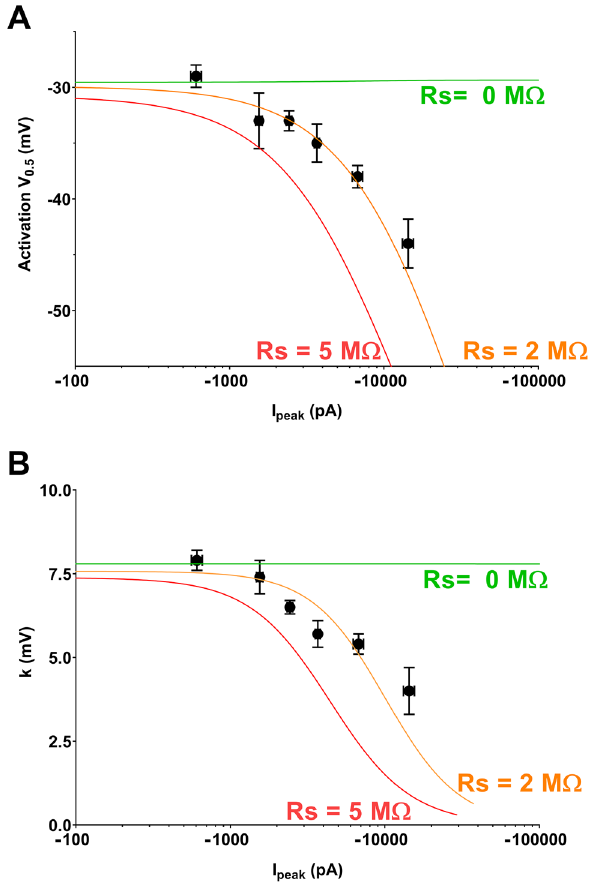
Figure 7. V 0.5 vs. amplitude plots and slope vs. amplitude plots of heterologously-expressed Na v 1.5 currents recorded in COS-7 using manual patch-clamp. ( A ) Symbols represent the mean ± sem of pooled experimental values of V 0.5 as a function of mean ± sem values of current amplitudes. Lines correspond to fit of computed values obtained from the kinetic model that has been optimized in Fig. 6 and in which R S has been set to 0, 2 and 5 M (cid:31) (compensated C m = 20 pF). ( B ) Pooled experimental values of the activation slope as a function of mean ± sem values of current